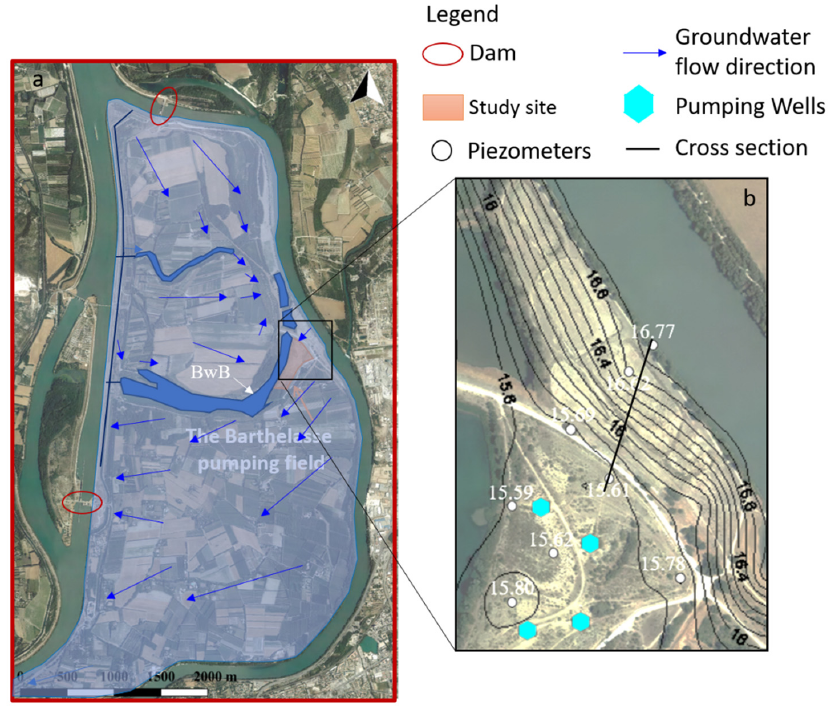
Figure 4. ( a ) Map of local groundwater flow directions. ( b ) Piezometric map of the study